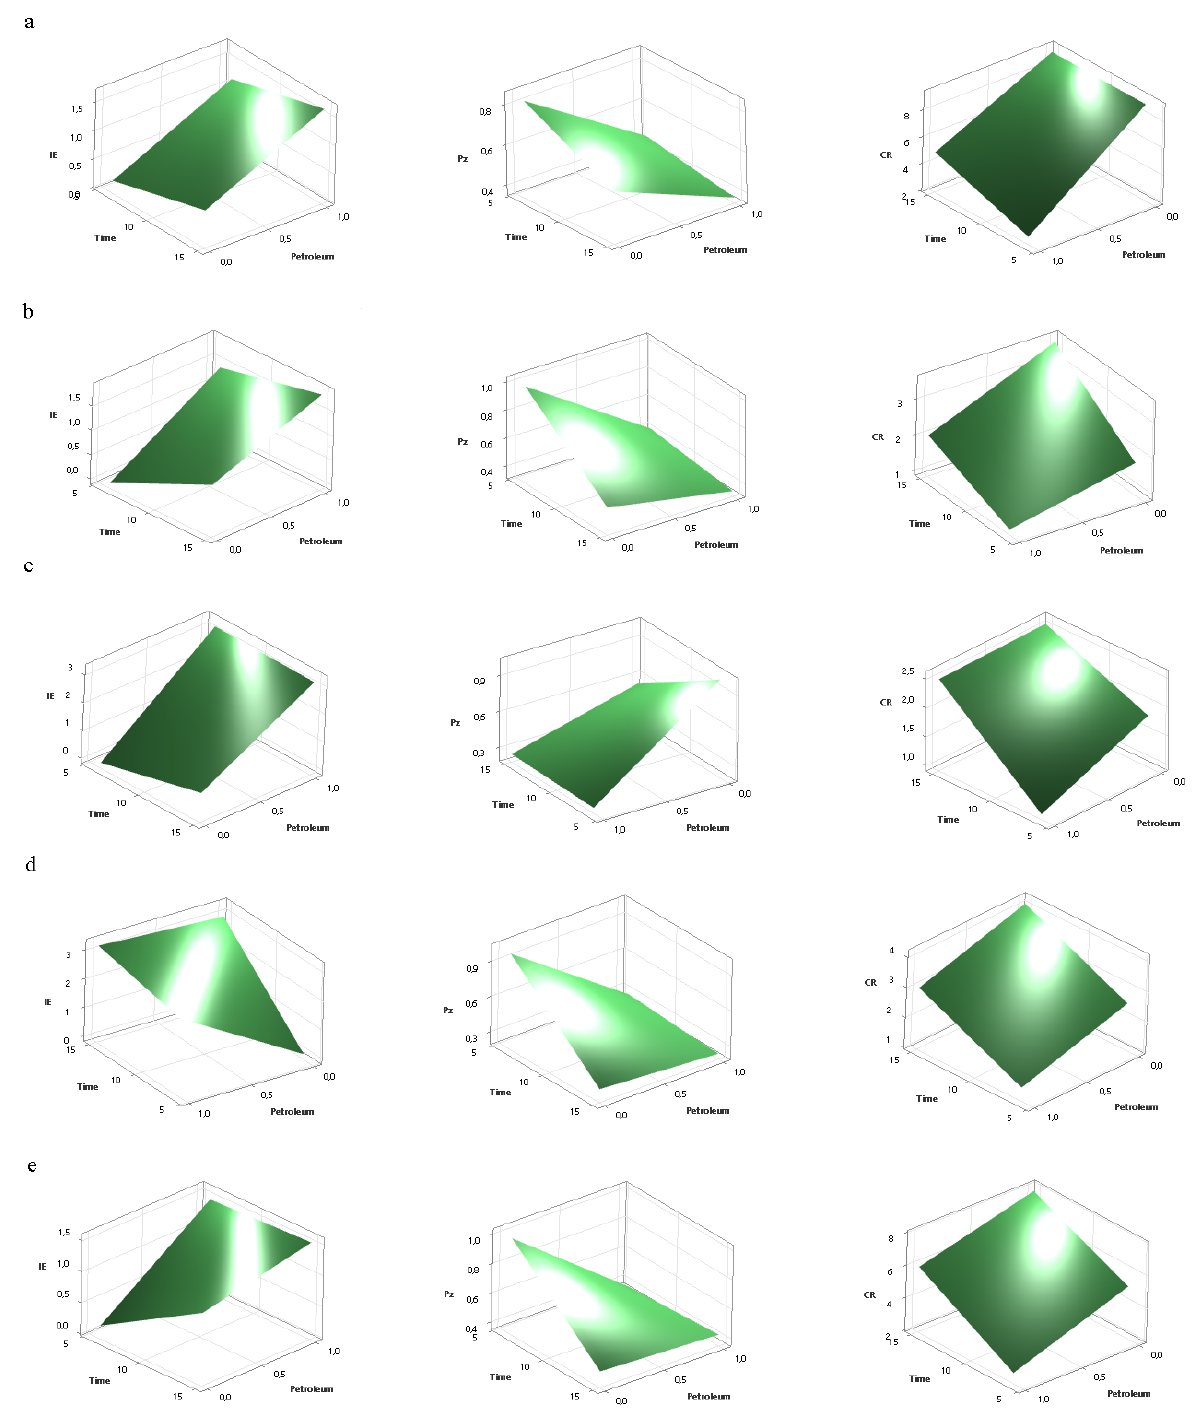
Figure 2. Three-dimensional response surface plot for MnP production using Aspergillus sp. (a), Penicilium sp. 1 (b), Penicilium sp. 2 (c), Penicilium sp. 1R26 (d) and Byssochlamys sp. (e) in solid